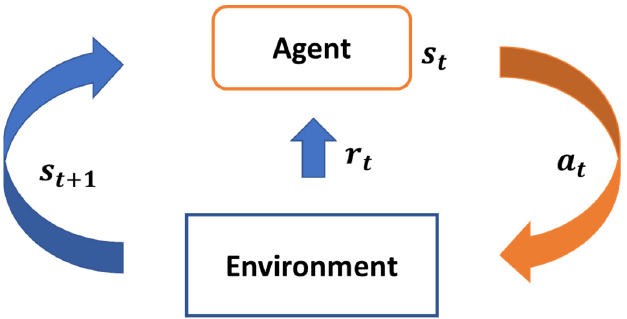
Figure 1. Agent–environment interaction in RL (modified from